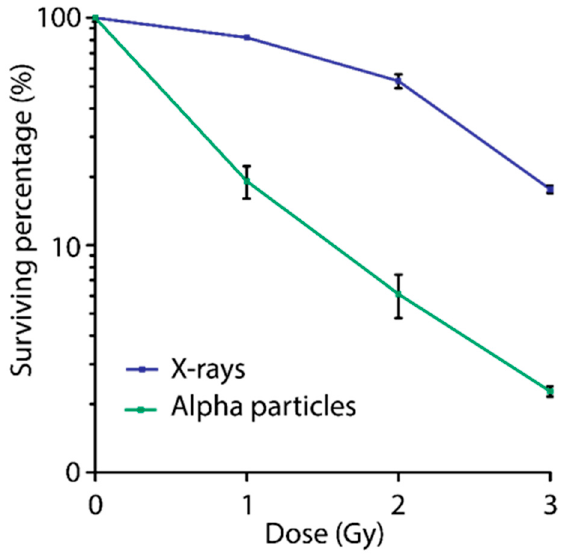
Figure 4. Clonogenic survival curve for U2OS cells irradiated using the alpha particle irradiation or X-rays. U2OS cells were seeded in Mylar dishes and treated with 1, 2 or 3 Gy of irradiation using both alpha particles or X-ray. Cells were trypsinized and seeded in triplicate. Colonies allowed to grow for 7 days (n = 3).